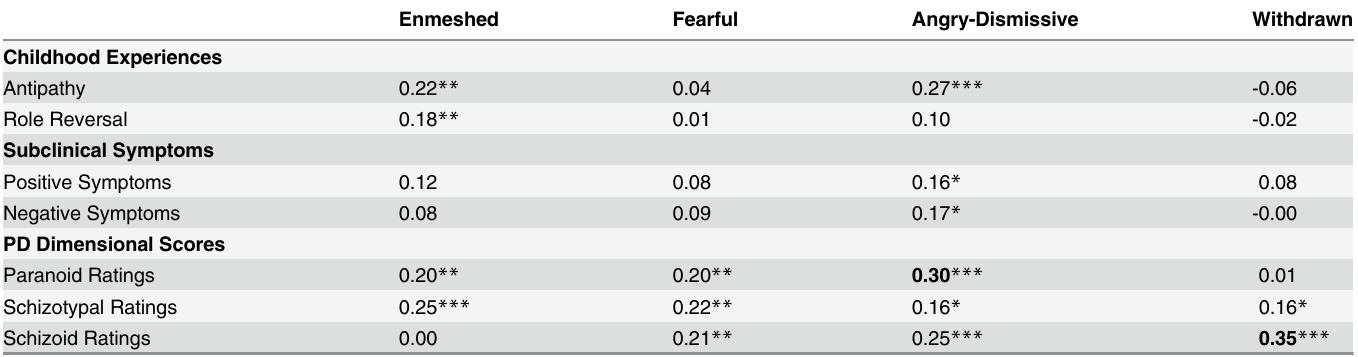
Table 3. Partial Correlations of Levels of Insecurity of Attachment Style with Antipathy, Role Reversal, and Schizophrenia-Spectrum Phenomenology.